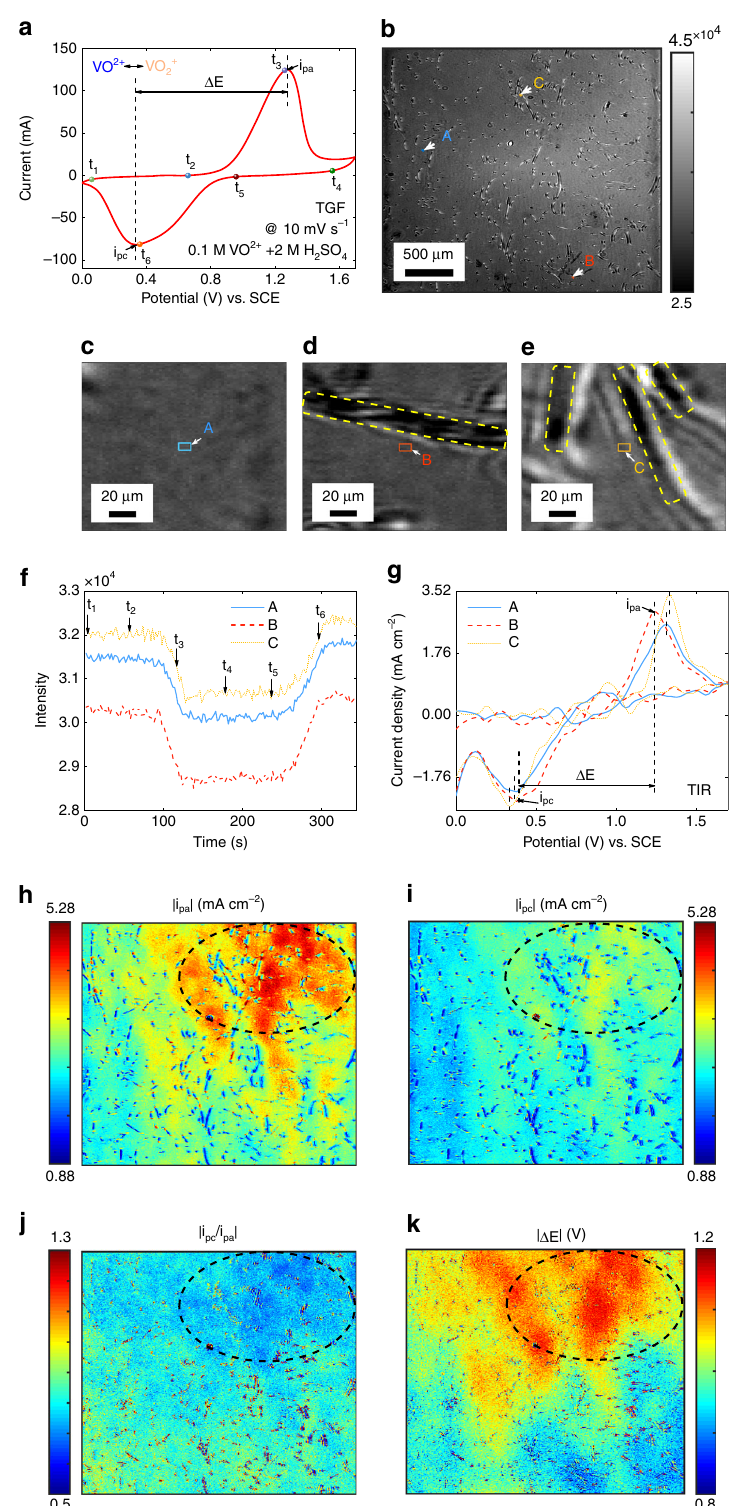
Fig. 2 Flow charts of obtaining current density distribution by the captured images. a CV curve of a TGF in the positive electrolyte of 0.1 M VO 2 + and 2 M H 2 SO 4 at a scan rate of 10 mV s − 1 recorded by EW. b Image captured by CCD at 0 V. c – e The enlarged views labeled as A, B and C in b respectively. Yellow dashed rectangle: carbon fi ber contacted with the prism. f Time-varying averaged intensities of the rectangle area (5 × 5 pixels) labeled as A, B and C in b during the CV. g CV curves obtained by convolution calculation based on the data in f . h – k The mappings of the peak oxidation current densities (| i pa |), the peak reduction current densities (| i pc |), the ratio of two peaks (| i pc / i pa |) and the peak potential separation value (| Δ E